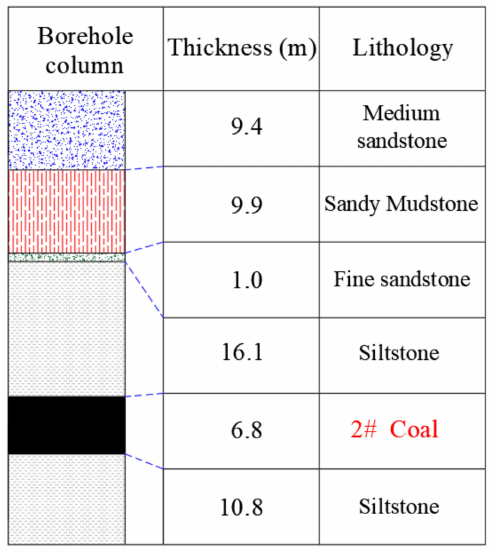
Figure 2. Mechanical parameters of rock strata. Table 1. Rock occurrence and mechanical